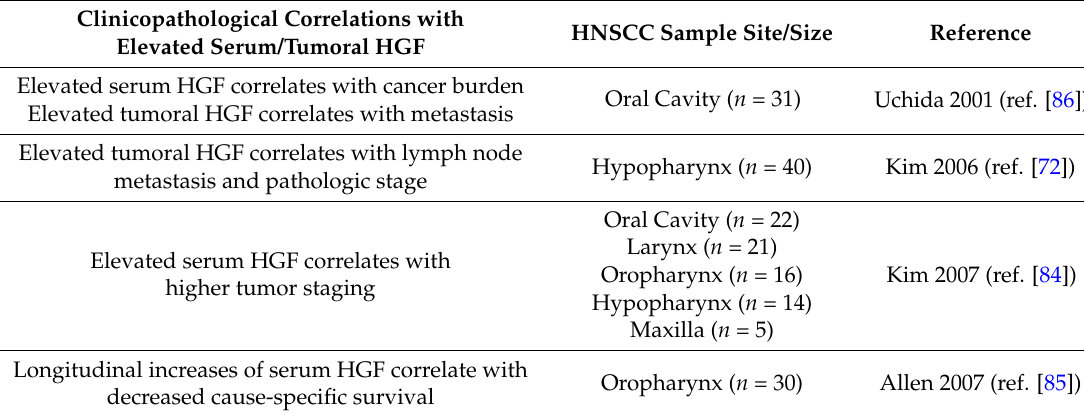
Table 2. Clinical Correlations with HGF Expression in HNSCC Tumors or